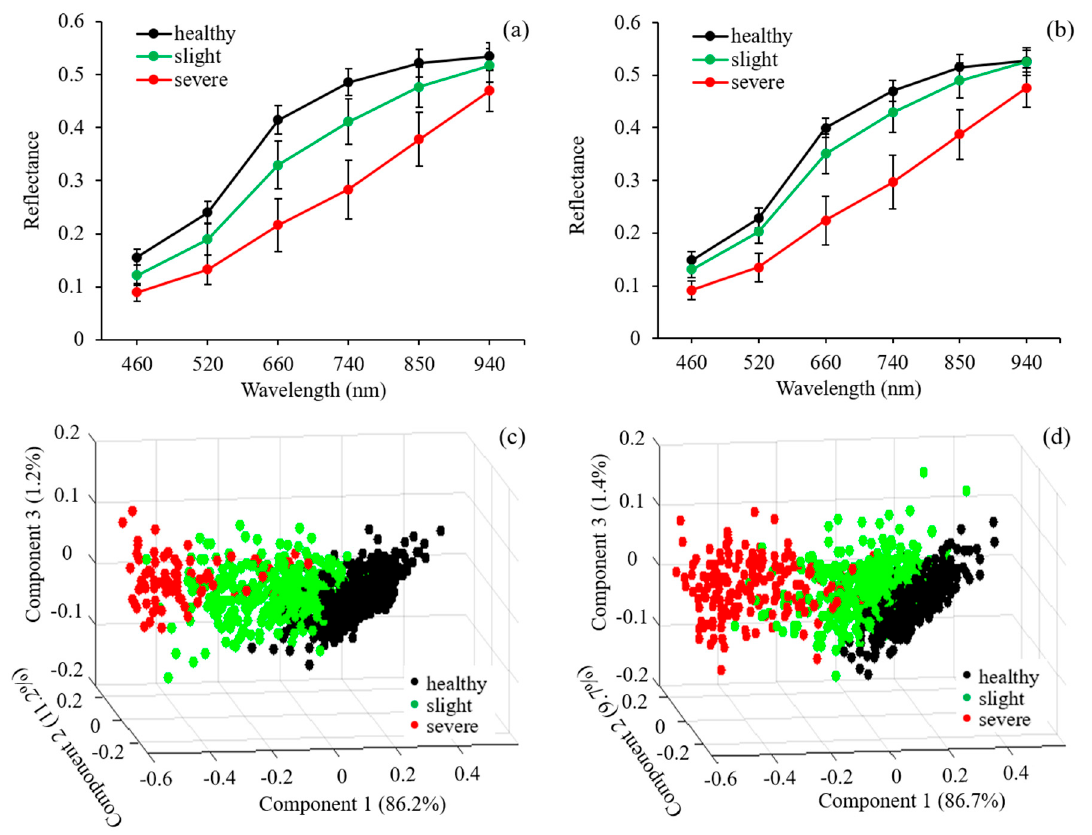
Figure 4. Mean reflectance spectra of healthy and rice false smut (RFS) infected rice seeds of Zheliang ( a ) and Xiushui ( b ). Principal component analysis of reflectance at six wavelengths in healthy, slightly, and severely infected rice seeds of Zheliang ( c ) and Xiushui ( d ).